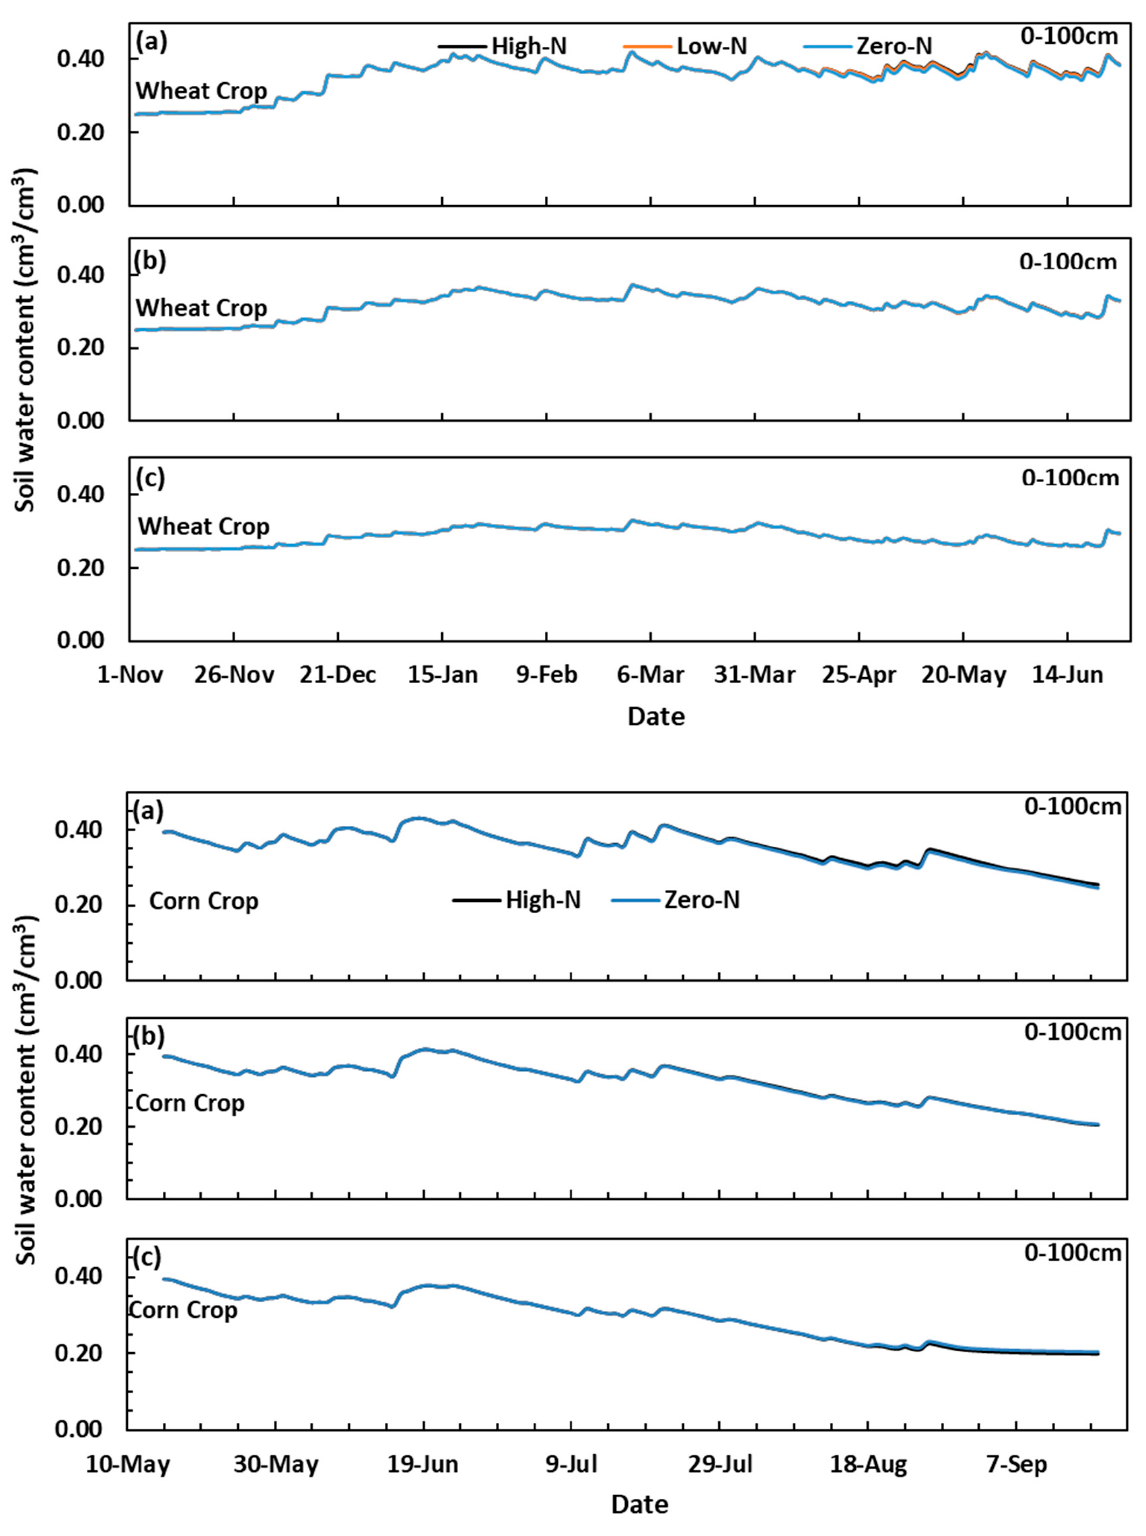
Figure 5. Model-simulated soil water content with time for a 0–100 cm soil depth, during the wheat and corn growing seasons under the ( a ) 125%, ( b ) 75%, and ( c ) 50% rainfall scenarios.